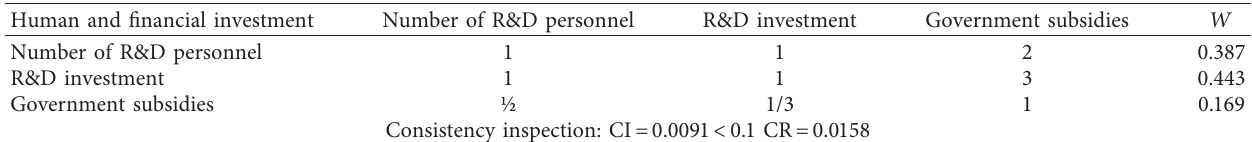
Table 5: Human and financial investment judgment matrix.